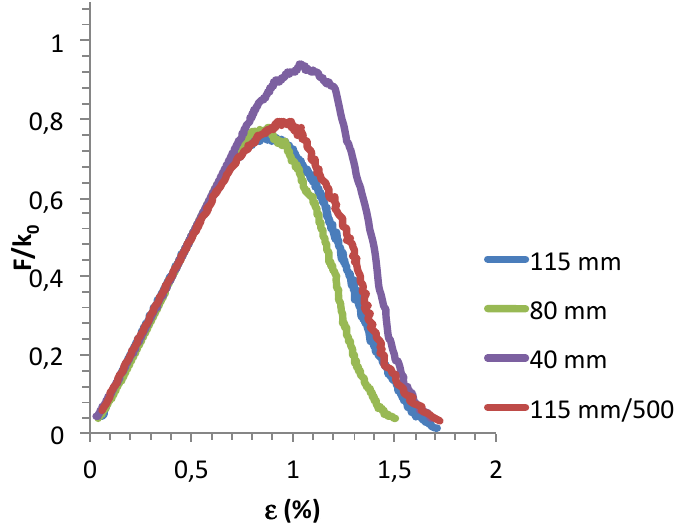
Figure 3. Typical F ( ε )/ k 0 vs. ε curves for various gauge lengths; 115 mm/500 refers to a tow with Figure 3. Typical F( ε )/k 0 vs. ε curves for various gauge lengths; 115 mm/500 refers to a tow with 500 500 filaments.